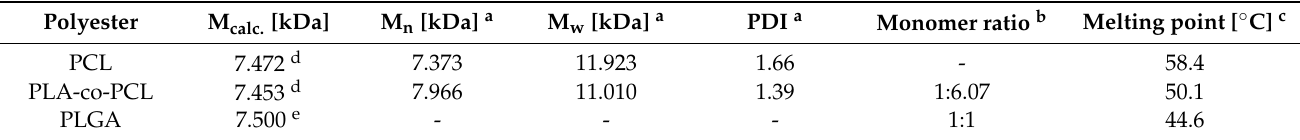
Table 1. Physicochemical properties of polyesters utilized in core formulation.